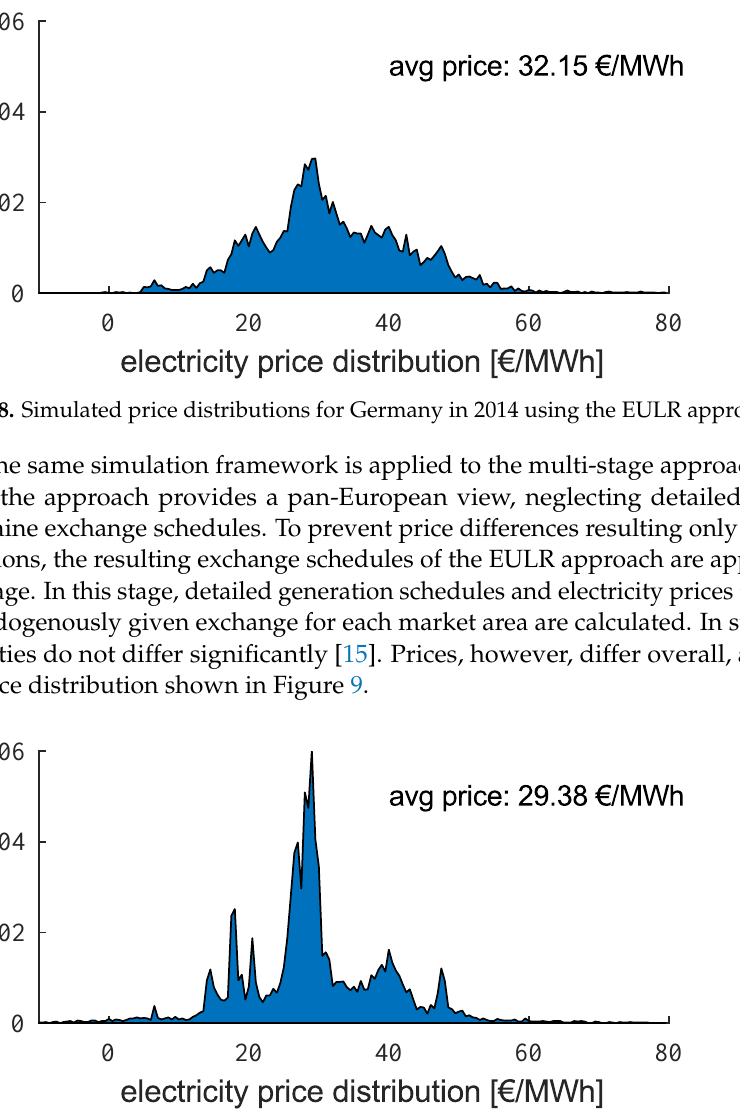
Figure 9. Simulated price distributions for Germany in 2014 in a multi-stage approach using the exchange schedules calculated in the EULR approach